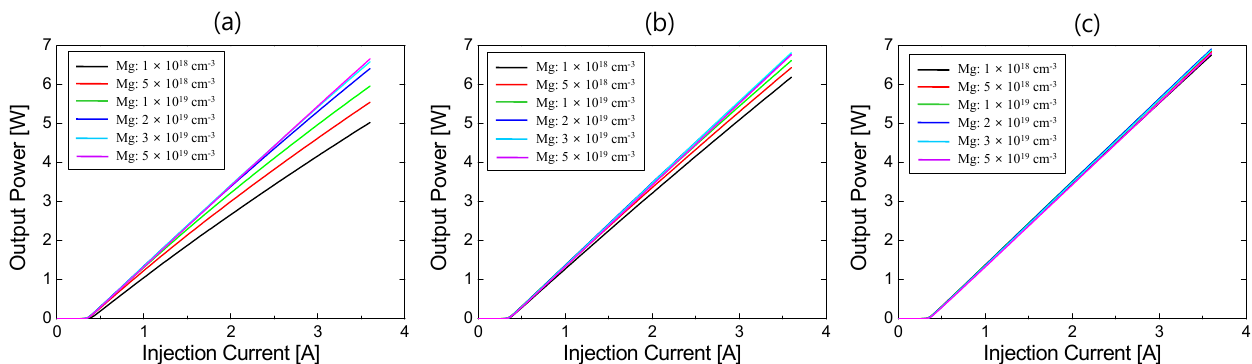
Figure 6. L–I curves of LDs for various Mg doping concentrations from 1.0 × 10 18 to 5 × 10 19 cm − 3 in the AlGaN EBL when the Al composition of the EBL was ( a ) 15%, ( b ) 20%, and ( c ) 25%.